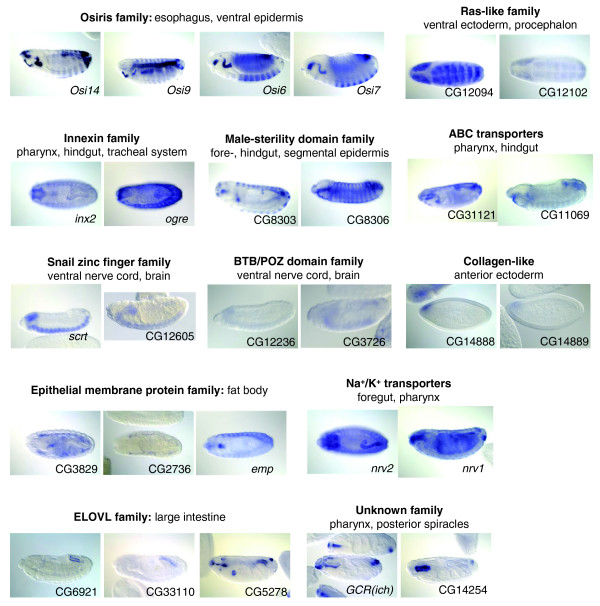
Conserved TDGs show co-expression in the Drosophila embryo. The figure shows in situ hybridization data for TDGs whose expression has not been previously described. Four genes from the Osiris cluster are expressed in the esophagus and in the ventral ectoderm, while three genes encoding Elongation-of-very-long-fatty-acids synthases (ELOVL) are expressed in the large intestine. We also found two undescribed genes that encode proteins with collagen-like repeats that are both expressed in a discrete domain at the anterior end of the syncitial blastoderm stage embryo, and two Ras-family members that show expression in the procephalon and ventral ectoderm. We have also found that the scrt Snail-type zinc finger gene has a conserved linked duplicate and both are expressed in overlapping domains in the central nervous system.